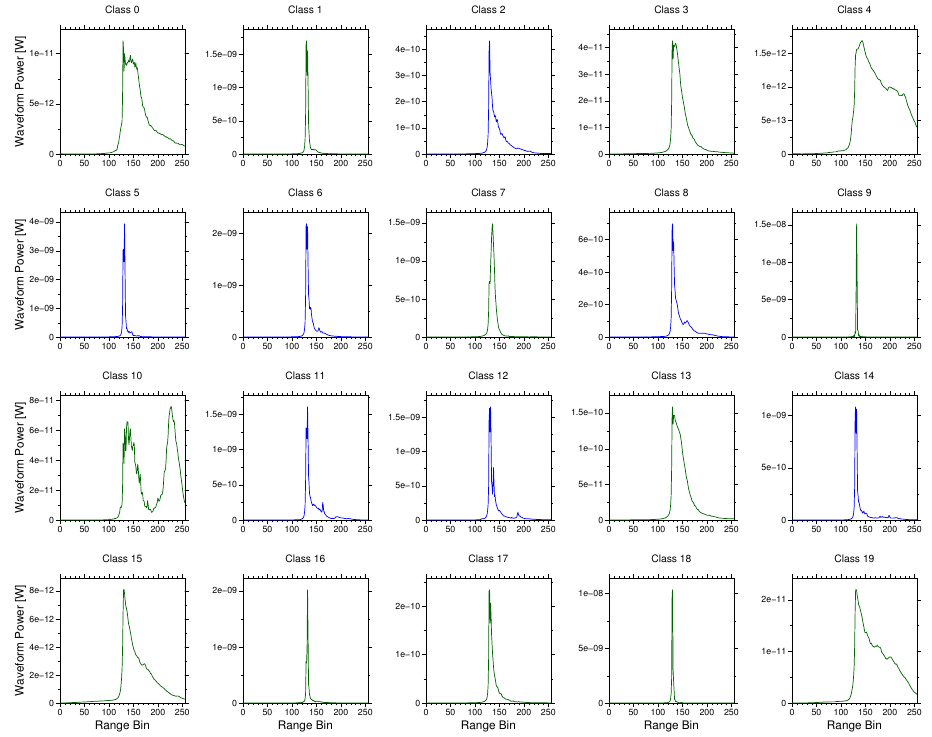
Figure A3. Middle region mean waveforms. Water classes: 2, 5, 6, 8, 11, 12, 14.